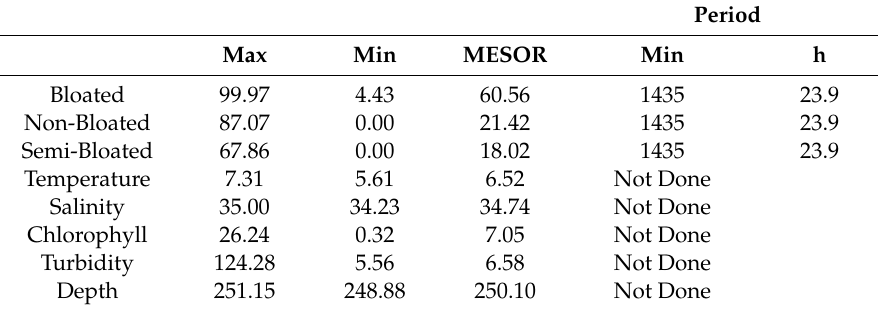
Table 3. Time series parameters as absolute maximum and minimum as well as significant ( p > 0.05) periods (both in total minutes (Min) and hours (h)) for all behavioral and oceanographic variables measured at the LoVe observatory in 2018. The Midline Estimated Statistic of a Rhythm (MESOR) is also reported as a result from waveform analysis for all the time series.